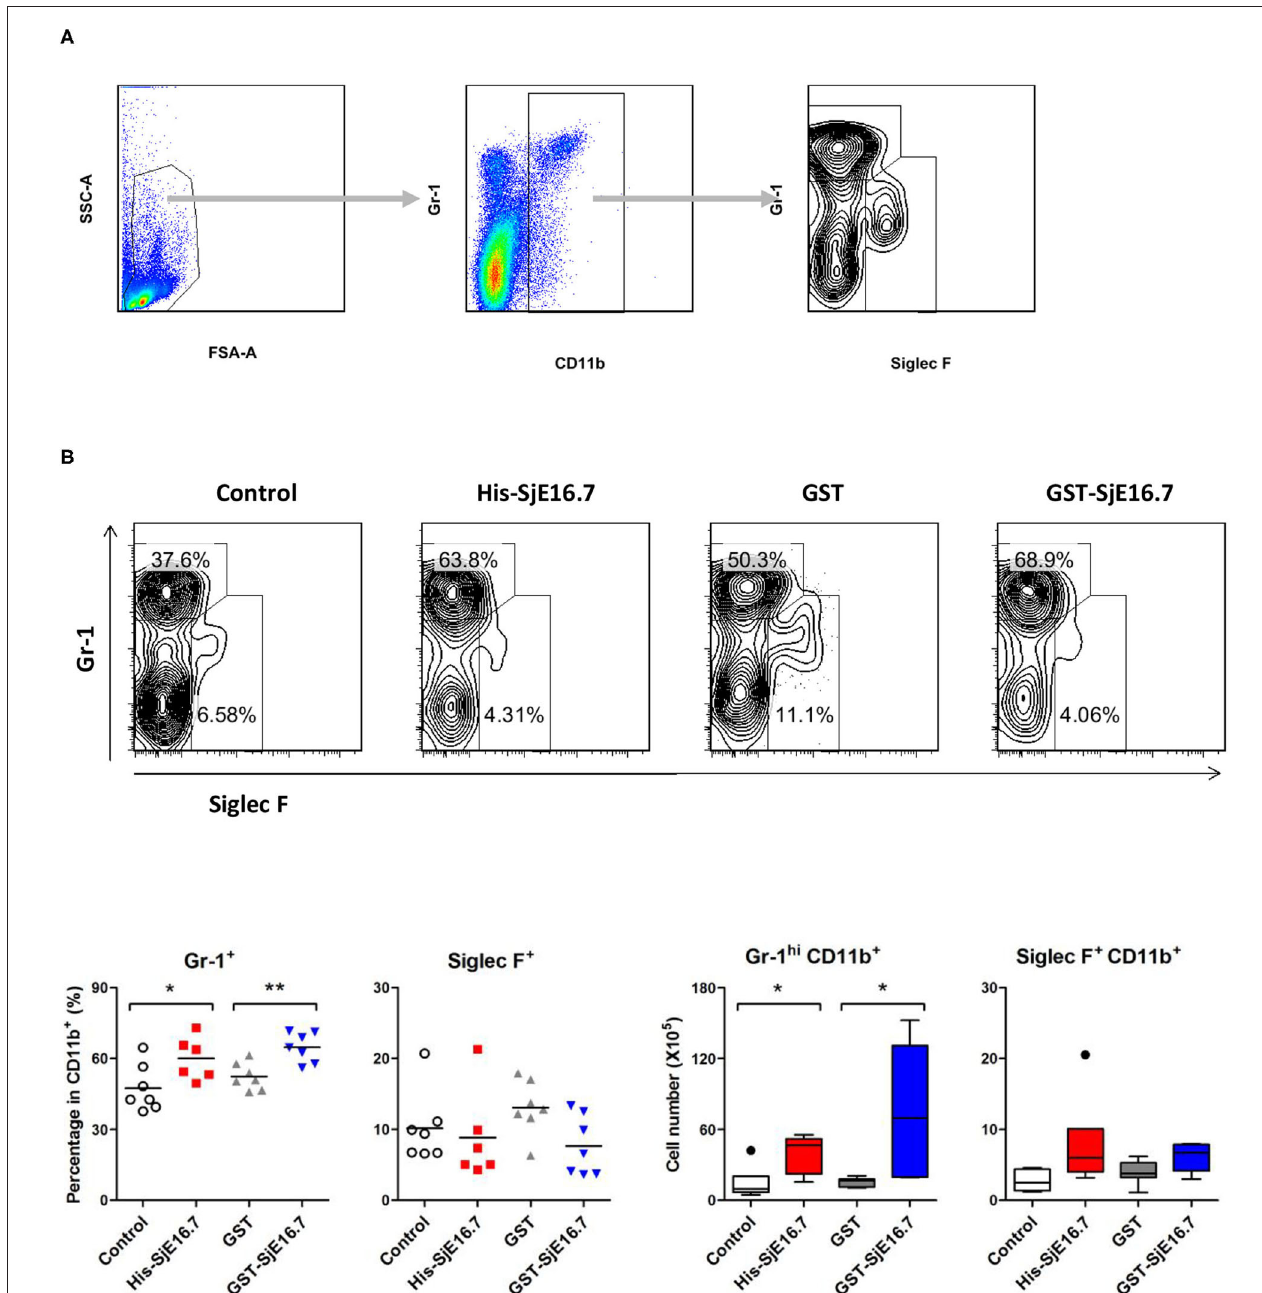
FIGURE 7 | SjE16.7 administration increases CD11b + Gr-1 hi myeloid cells in the spleen of the CAC mouse model. Splenocytes were isolated from His-SjE16.7, GST-SjE16.7, GST-control, or PBS control treated mice 14 weeks post-CAC induction. (A) Representation of the flow cytometry gating strategy for the determination of splenic CD11b + myeloid cells subpopulations. (B) Frequency and absolute number of Gr-1 hi and Siglec F + cells within the CD11b + myeloid population was determined by flow cytometry. The frequency and number of CD11b + Gr-1 hi and CD11b + Siglec F + cells in spleen are presented as the mean ± SEM of six to seven individual mice per group. * p < 0.05, ** p < 0.01 compared with indicated control